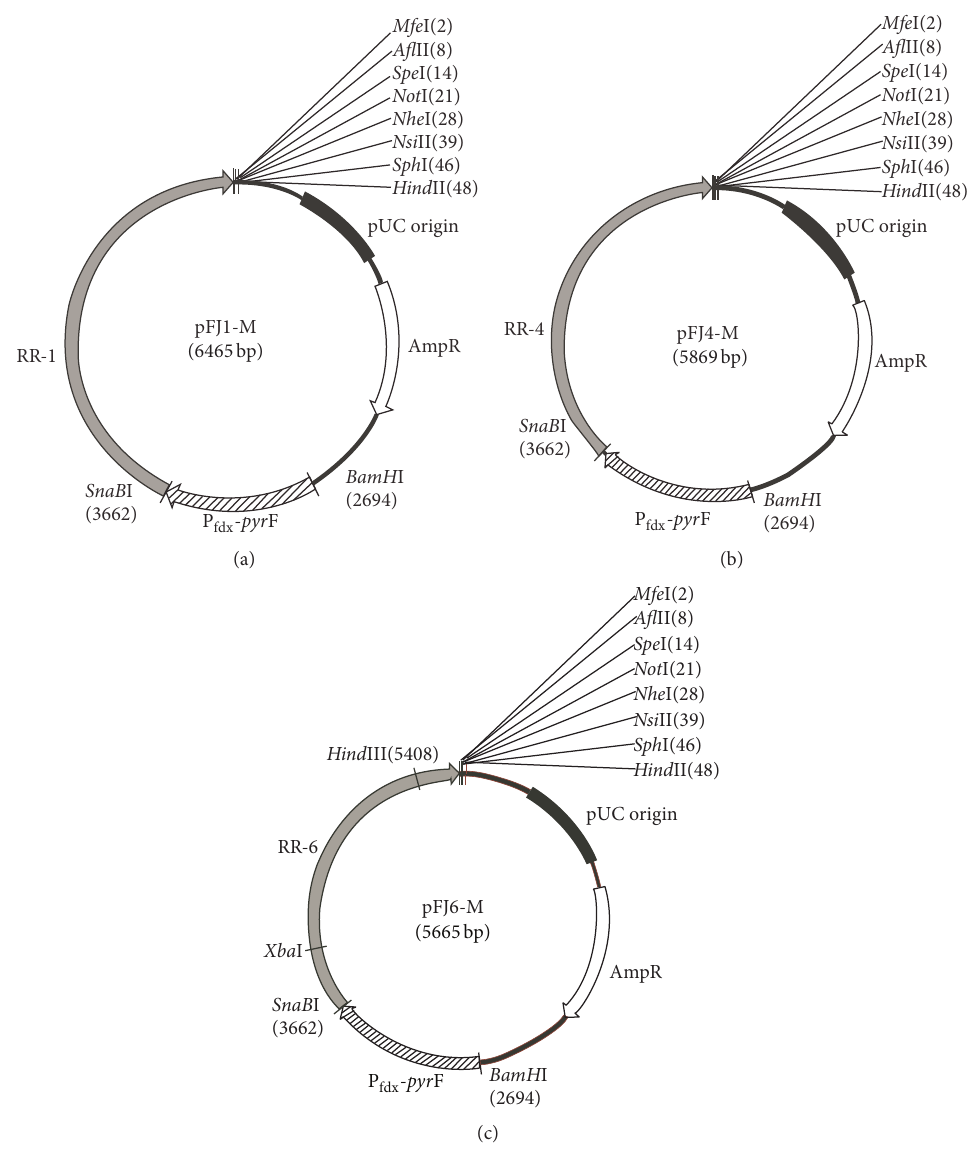
Figure 1: Physical maps of the pFJ1-M (a), pFJ4-M (b), and pFJ6-M (c) plasmids.